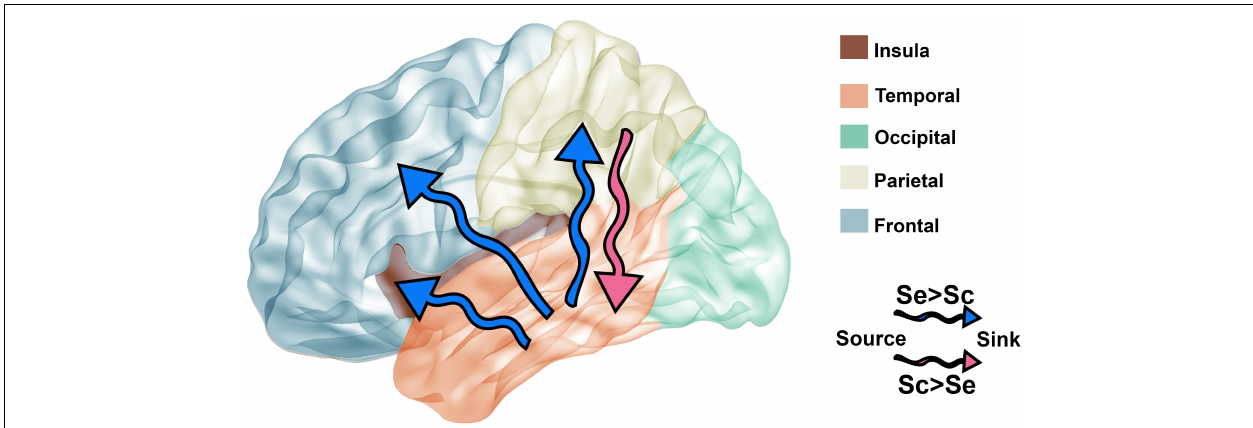
FIGURE 8 | Comparison of brain connectivity dynamics between Seq and Scr stimulus. Based on the connectivity results presented in Figure 7 , the directionality of the connectivity between brain regions is affected by the type of stimulus presented. Blue arrows represent the connectivity with significantly higher number of connections between source and sink during Seq, whereas the pink arrow represents the connectivity with significantly higher number of connections between source and sink during Scr. Connectivity from the temporal lobe to destinations: insular, parietal, and frontal lobes is higher during Seq vs. Scr (blue arrows). The parietal lobe has higher connectivity to the temporal lobe during Scr vs. Seq (pink